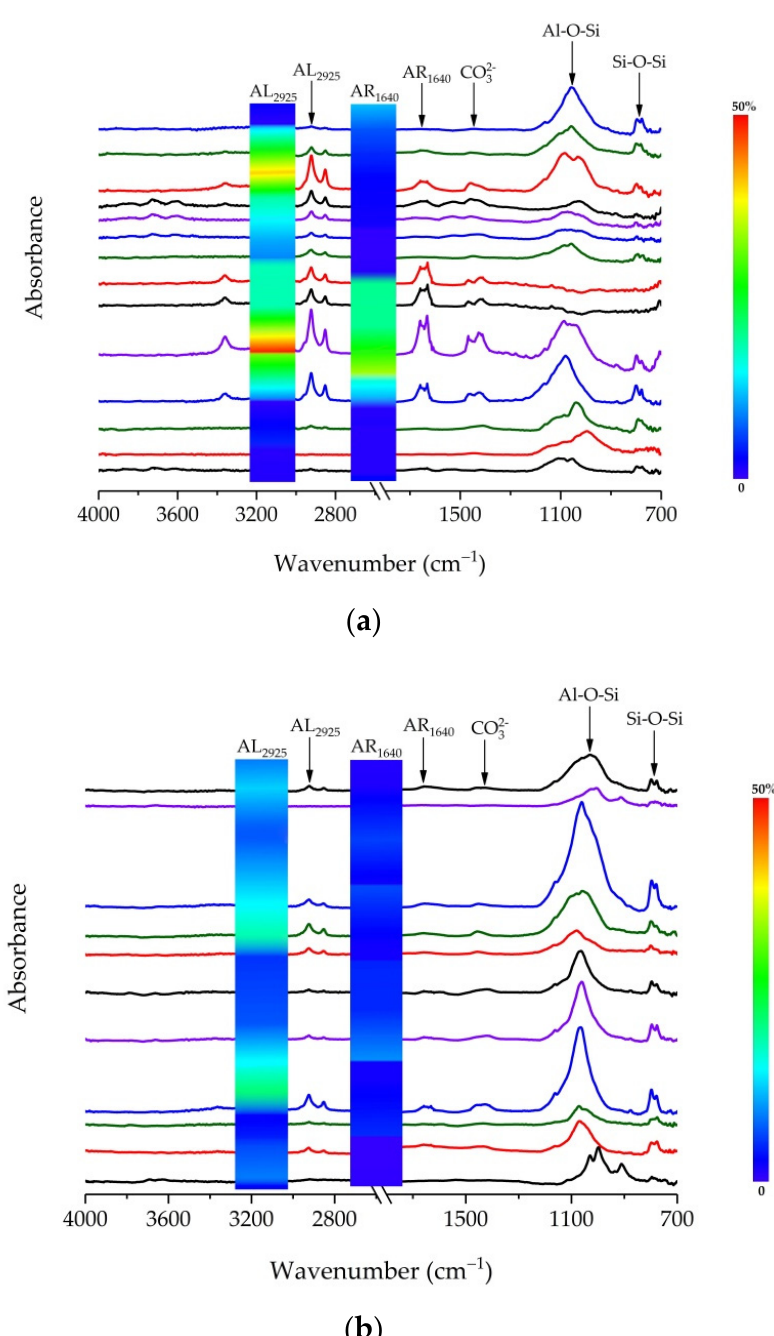
Figure 8. ATR spectra (FTIR-microscopy) and aliphatic and aromatic fragments content distri- bution plots for the Bazhenov Formation layered sample: ( a ) 14 measurements in light lamina; ( b ) 11 measurements in dark lamina.